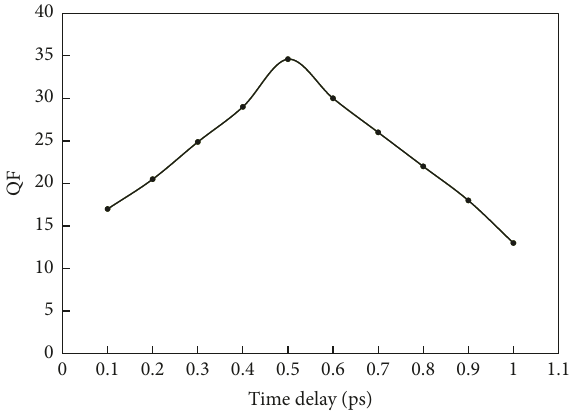
Figure6:QFversusSOA’straditionallinewidthenhancementfactor ( 𝛼 -factor) for AND operation at 𝑁